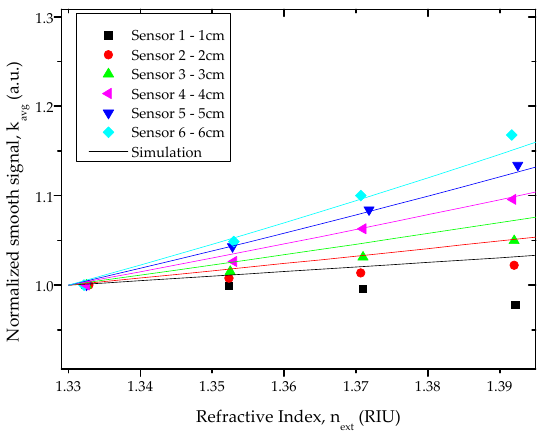
Figure 9. Experimental and simulation results: normalized smooth signal vs. refractive index for all D-shaped sensors in the RI range (1.33–1.39).